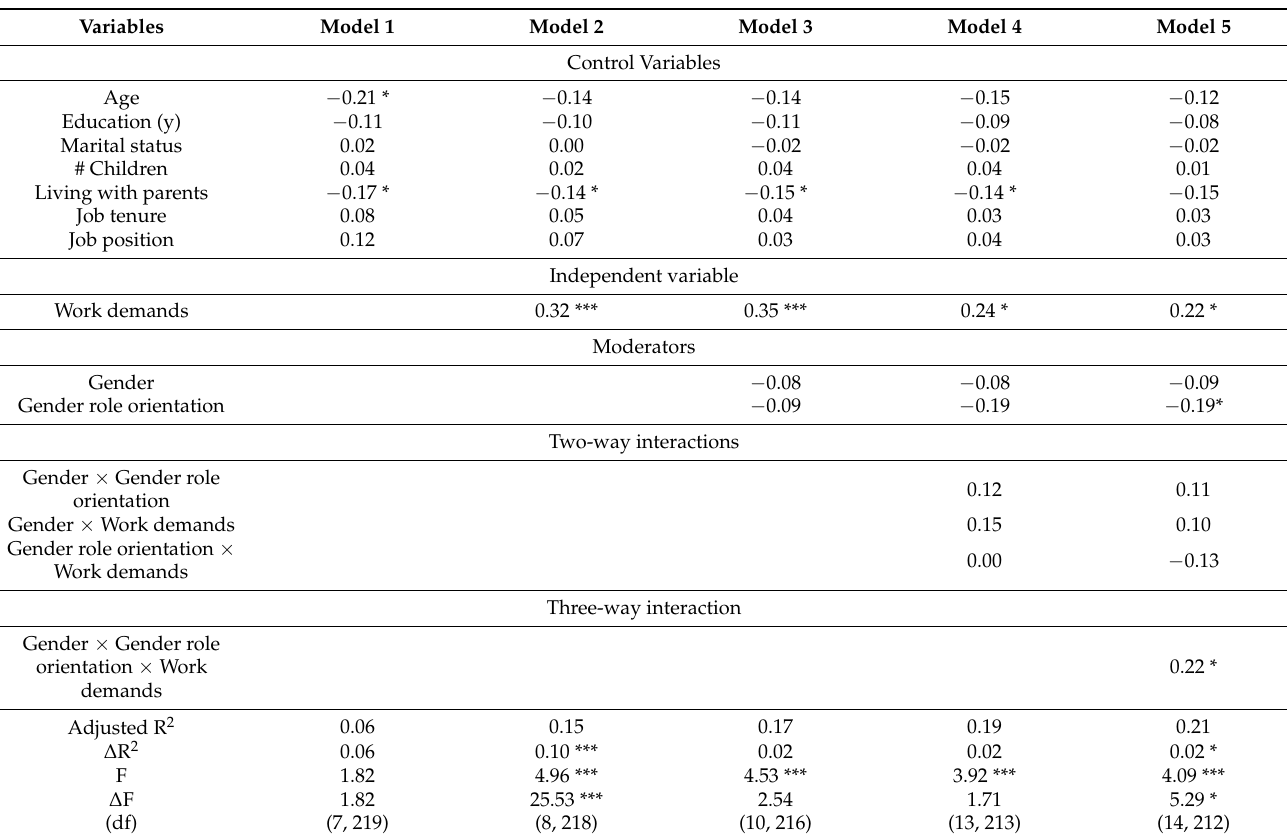
Table 3. Interactive effects of gender, gender role orientation, and work demands on family-to-work conflict (N = 251).